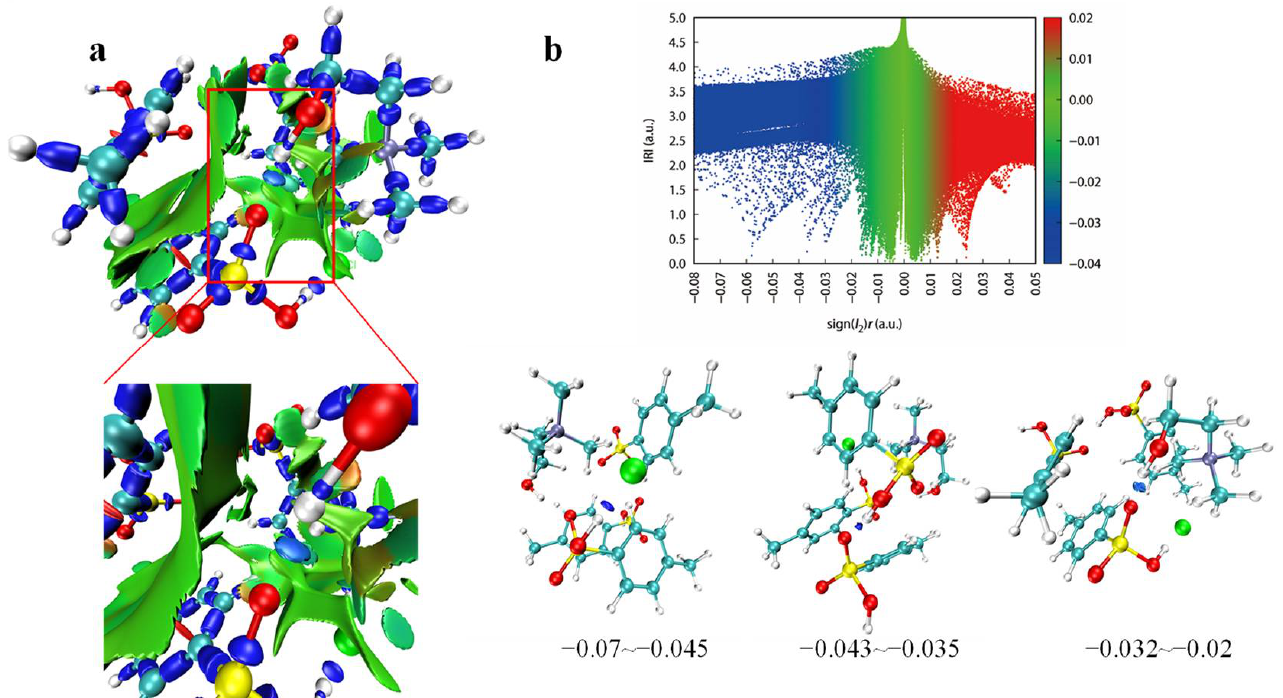
Figure 8. The independent gradient model based on the Hirshfeld partition ( a ), and NCI analysis of ChCl/PTSA (1:3) DES ( b ). The color from green to blue indicates the H-bonds moving from weak to strong.